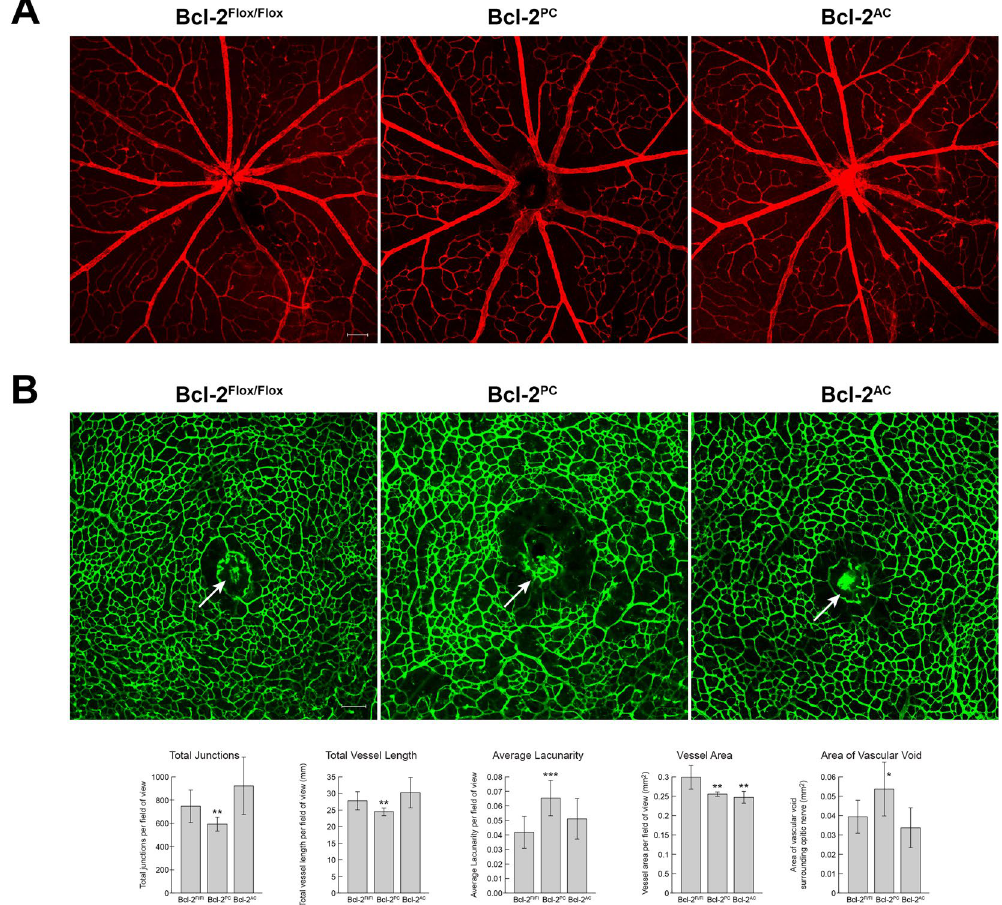
Figure 3. Aberrant vascularization of the central retina in Bcl-2 PC mice. In Panel A, retinas from P10 mice were wholemount stained with anti-collagen IV. Photomicrographs were taken of retinal arteries near the optic nerve. In Panel B, retinas from P10 mice were wholemount stained with Isolectin B4-FITC and the deep vascular plexus imaged surrounding the optic nerve. The arrow points to the optic nerve. Scale bar = 100 µ m (n = 5). Please note symmetrical branching of retinal arteries from Bcl-2 Flox/Flox and Bcl-2 AC mice but disorganized appearance of the vasculature in the retinas from Bcl-2 PC mice and void near optic